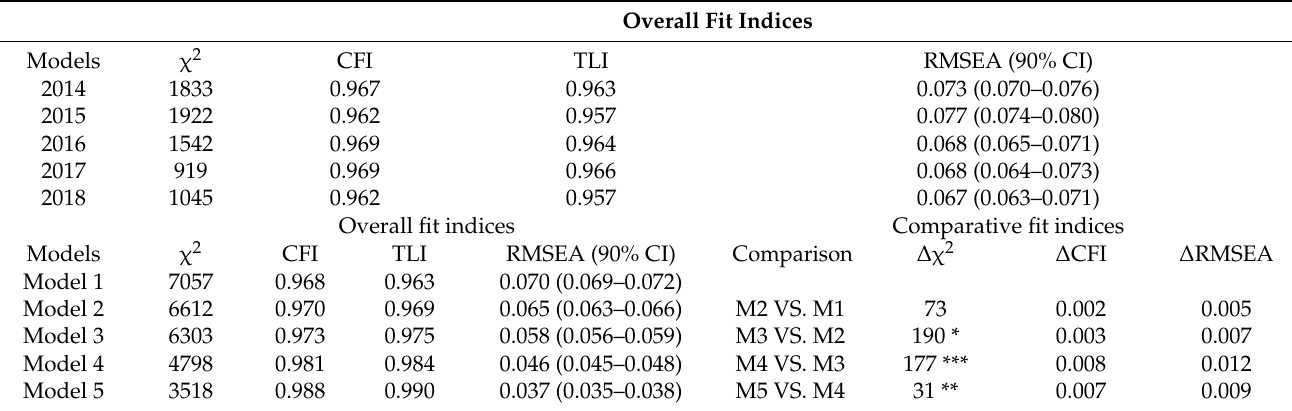
Overall Fit Indices